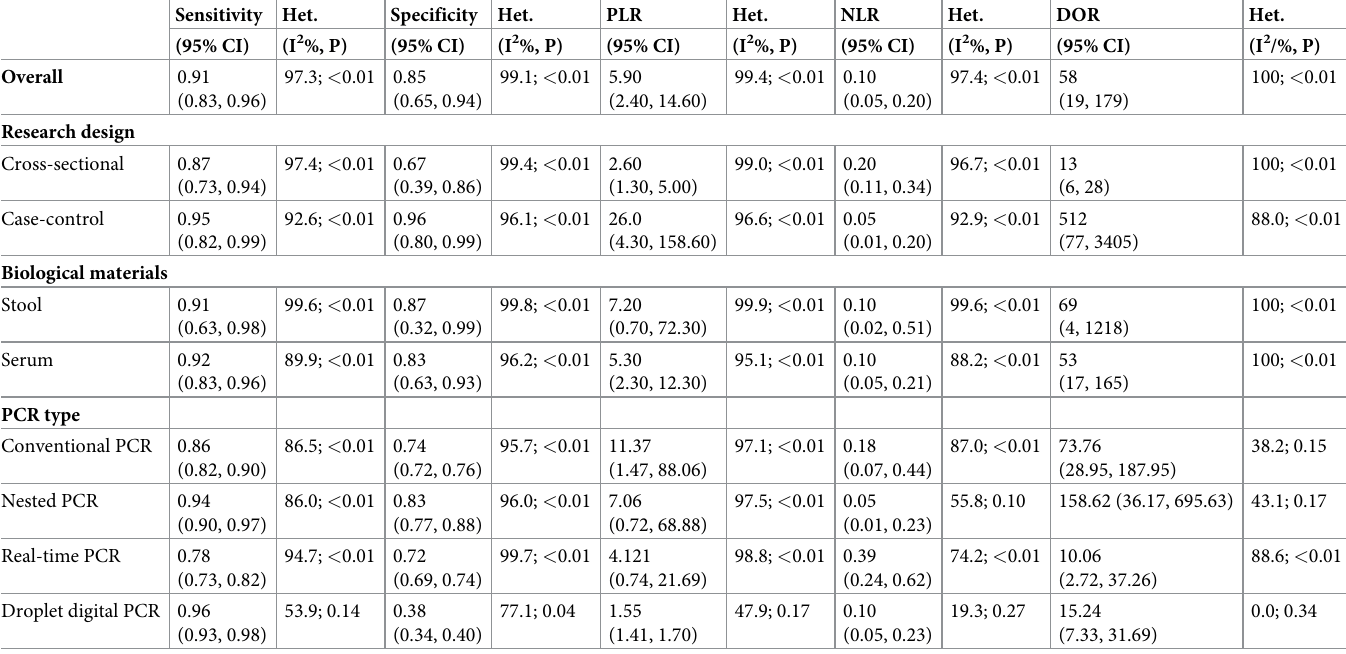
Table 3. Subgroup analysis of diagnostic accuracy. Sensitivity